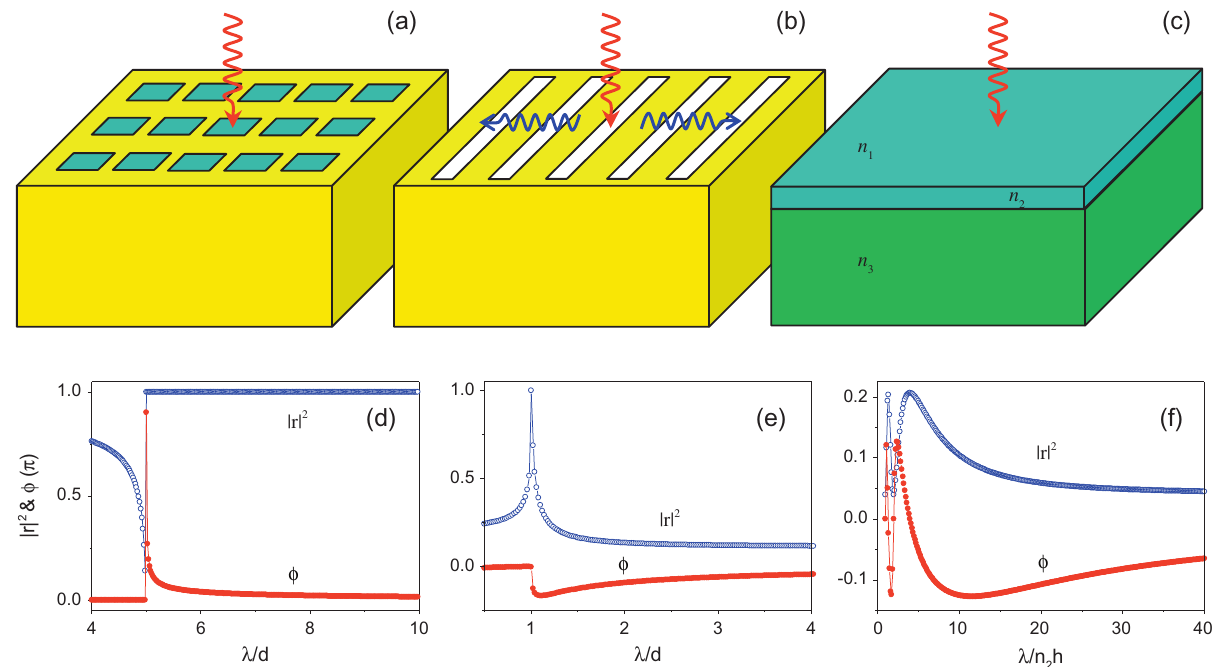
Figure 1. Reflection of light at various interfaces: (a) A semi-infinite PEC metal milled with subwavelength square holes behaves like an effective medium ( k (cid:3) d ) with a resonant impedance (the hole width is a , the period is d , and the permittivity of hole filling medium is set as e h = 25); (b) A semi-infinite PEC metal milled with periodic slits (the slit width is a and the period is d ) can induce the diffracted evanescent waves at the interface ( k ~ d ); (c) Light reflection by a dielectric slab (with a thickness h ) sandwiched between two semi-infinite media. The reflection efficiency and phase shift for the case (a)–(c) are shown in (d)–(f) respectively. We set in (d) and (e) a = d /2 and in (f), n 1 = 1, n 2 = 2, and n 3 =